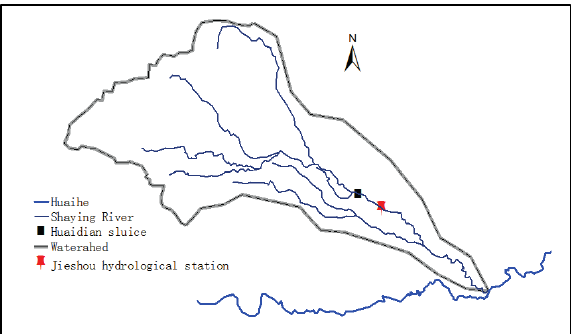
Fig. 1 Study area and the location of Jieshou hydrological